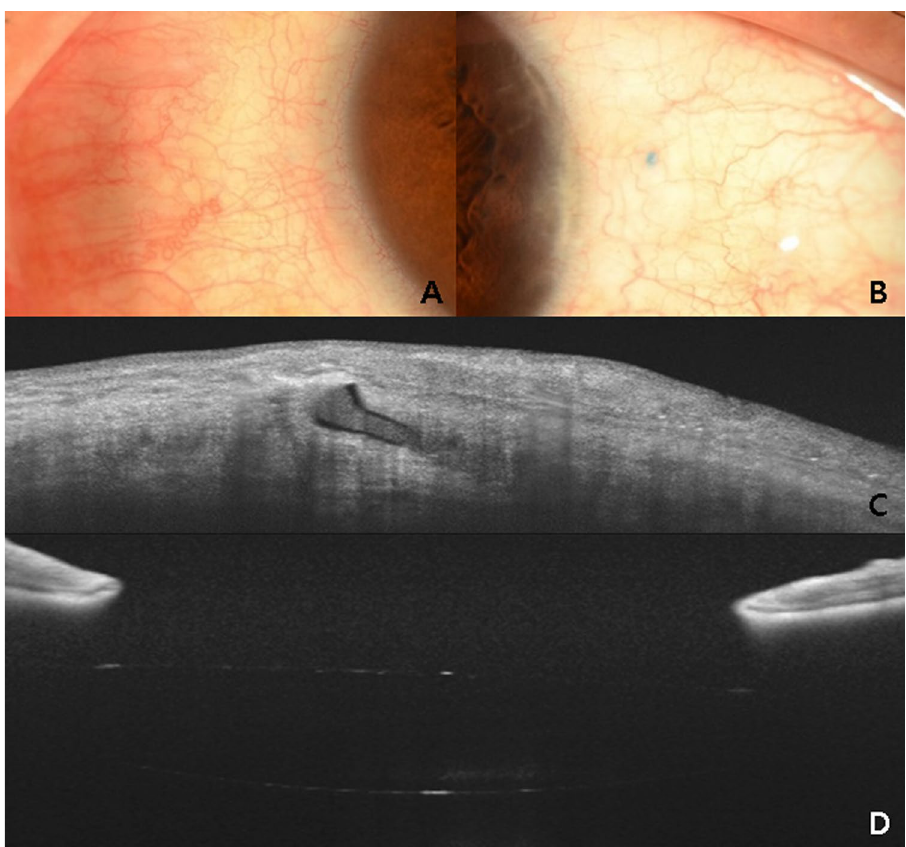
Figure 3. Postoperative findings of the flanged endings and intraocular lens six months after surgery. The uncorrected and best-corrected visual acuities were 20/33.3 (Snellen visual acuity) and 20/20 (Snellen visual acuity), respectively. ( A , B ) An image of the anterior segment showing intrascleral flanged endings without conjunctival erosion or flange exposure. © Optical coherence tomography (OCT) image of the anterior segment showing intrascleral flanged endings of the haptic shown in panel ( B ). The largest diameter of the flange was 300 µm. ( D ) OCT images showing no tilting of the intraocular lens.